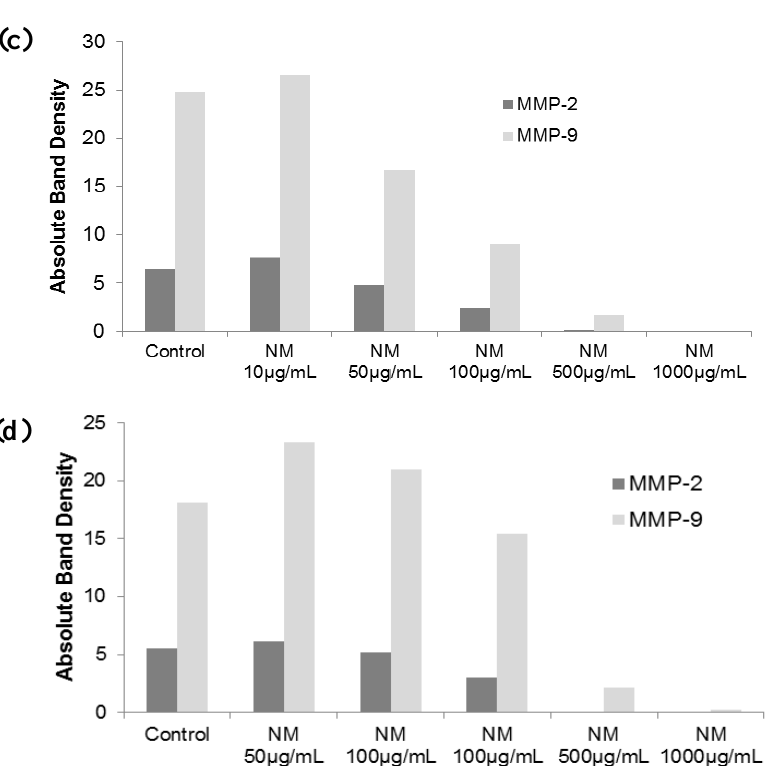
Figure 12. Effect of NM on SK-Hep-1 TIMPs secretion ( a ) gelatinase